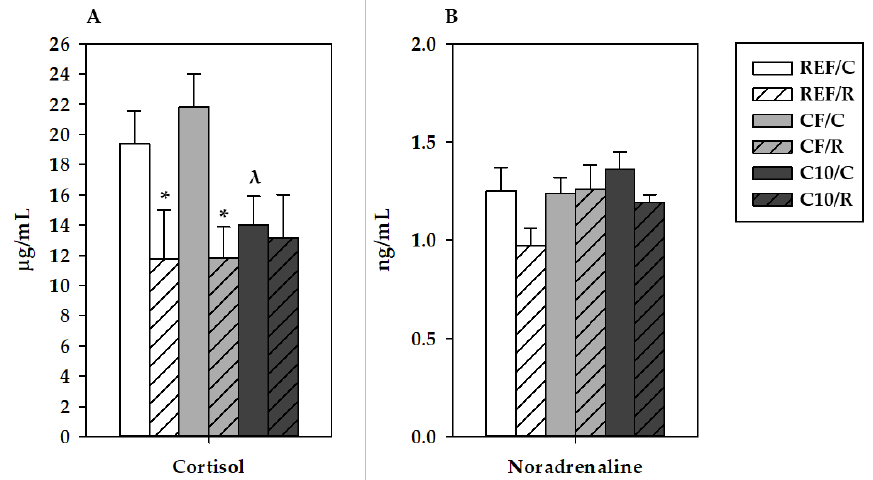
Figure 2. Plasma cortisol ( A ) and noradrenaline ( B ) concentrations 16 h after performing the final exhaustion test. REF, reference diet; CF, 5% cocoa fiber-enriched diet; C10, 10% cocoa-enriched diet. The control (C) groups are represented by smooth bars, and the runner (R) groups are represented by striped bars. Data are expressed as mean ± SEM (n = 8). Statistical differences (a Kruskal–Wallis test followed by a Mann–Whitney U test): * p < 0.05 vs. the C group in the same diet; λ p < 0.05 vs. the same exercise condition in the CF